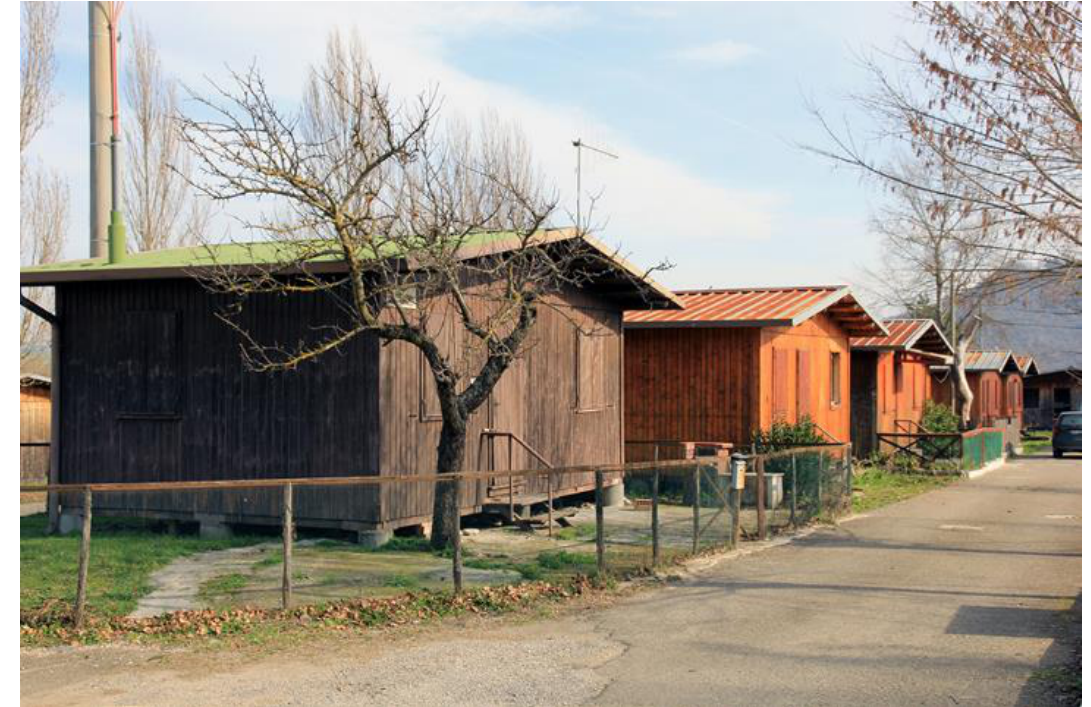
Figure 16. Conza della Campania: temporary village, consisting of wooden housing, built immediately after the earthquake of 1980 and now almost completely abandoned (photos by [35,36]).